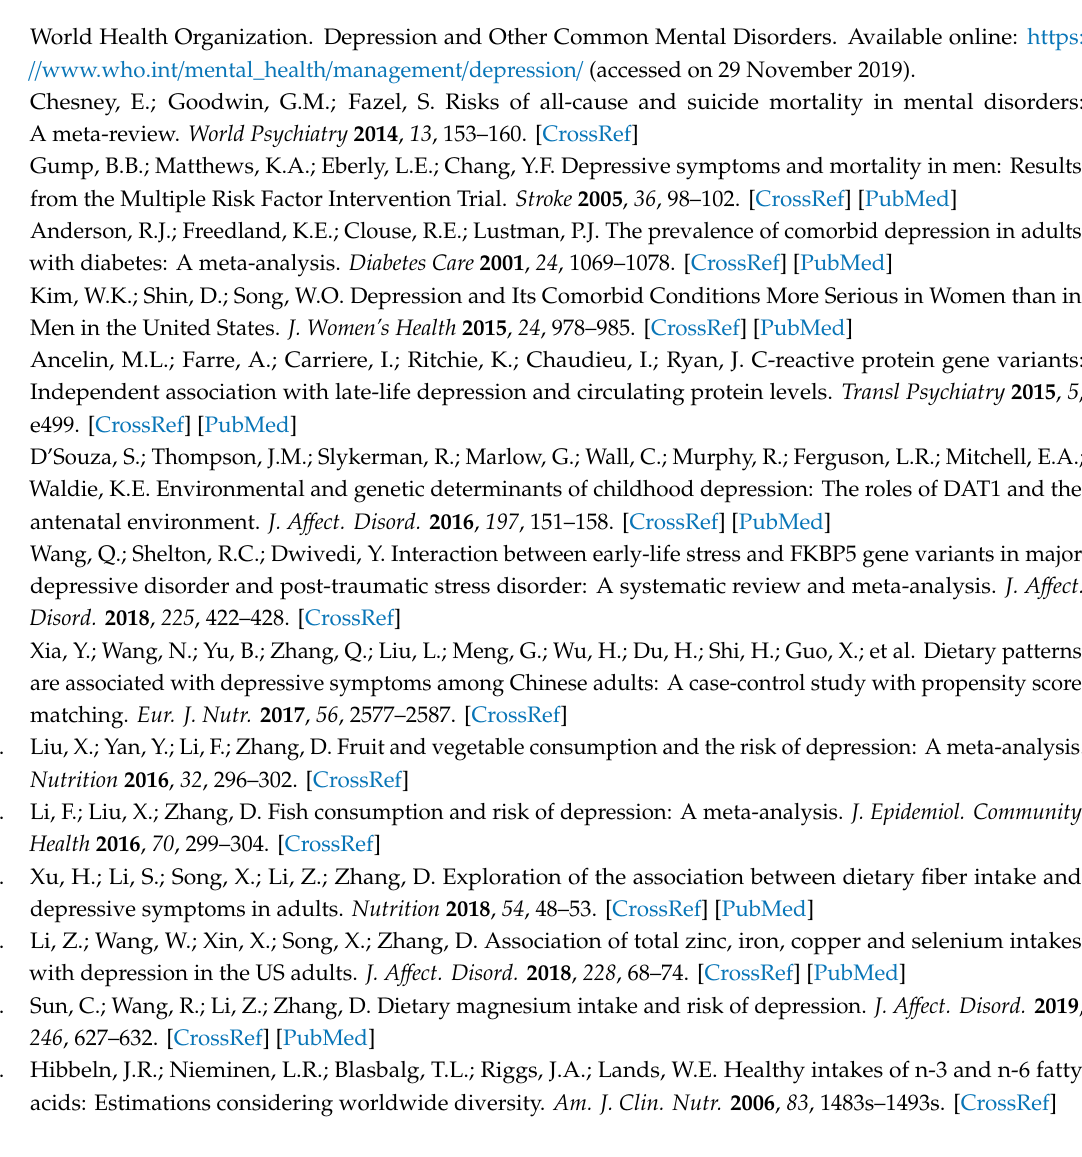
Table S1: The classifications of categorical